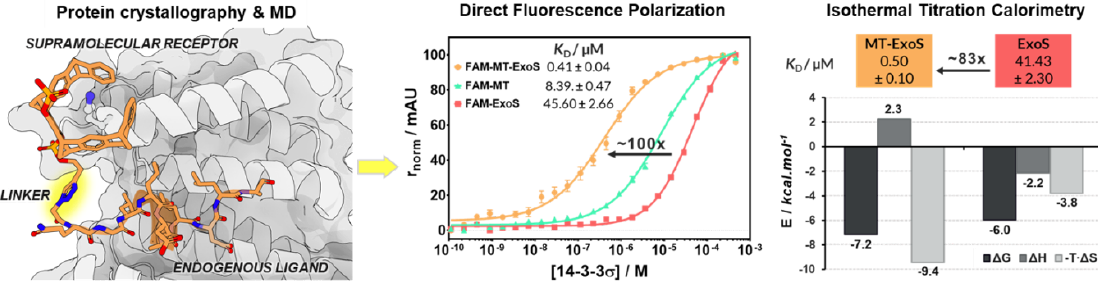
Figure 25. Crystal structure and biophysical characterization of the ditopic MT-ExoS ligand.